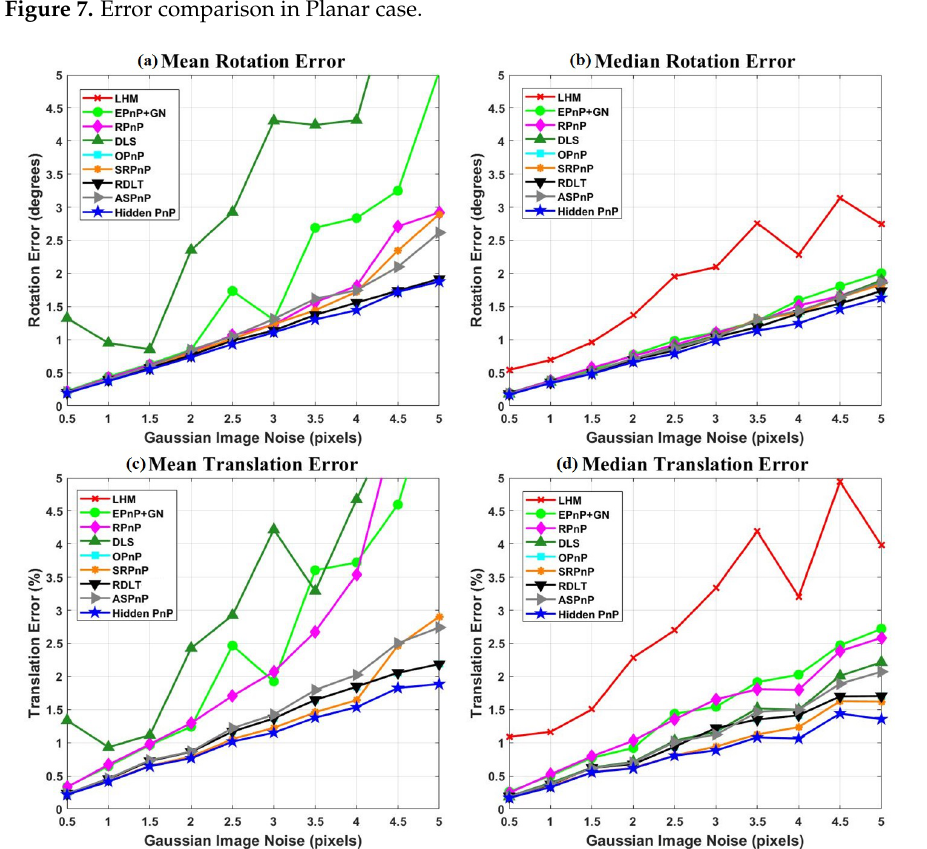
Figure 8. Error comparison in Quasi-singularity